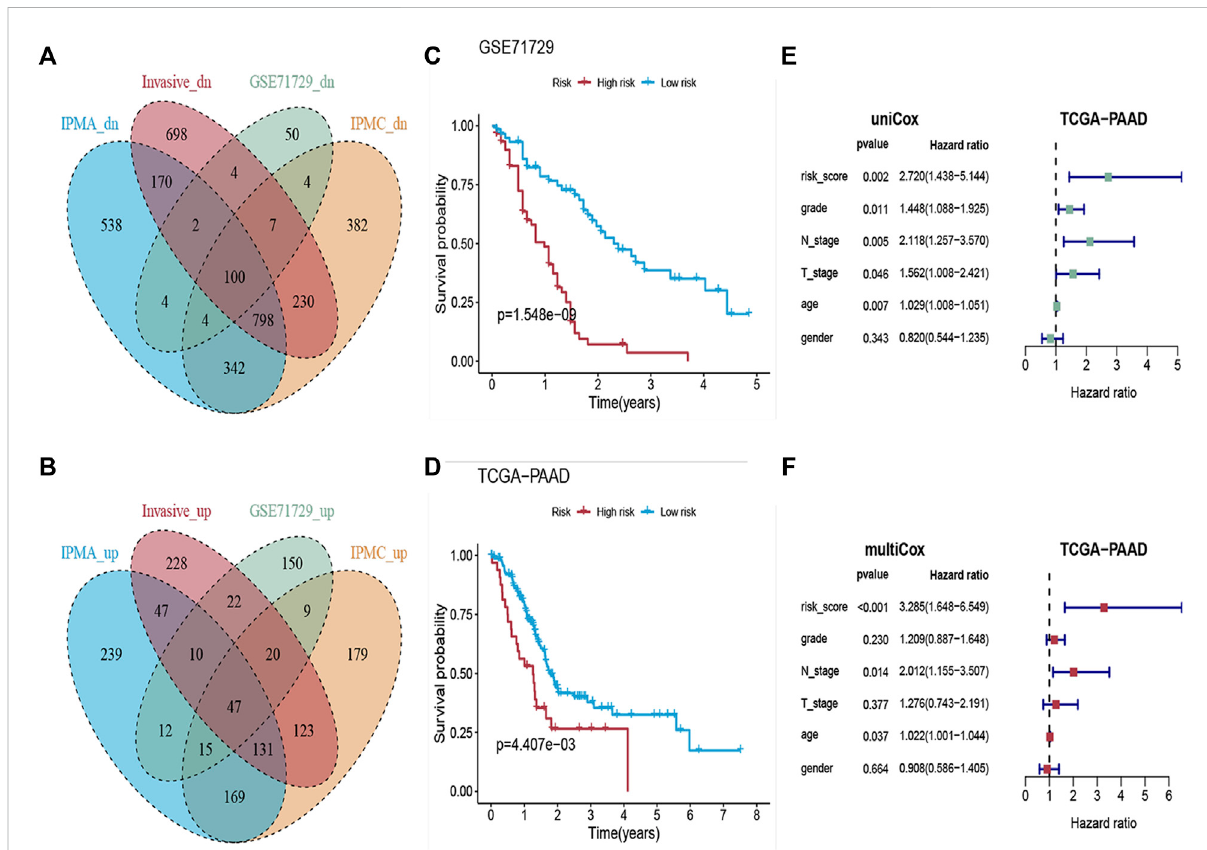
FIGURE 5 ConstructionoftheRisk-ScoringModel. (A,B) Venndiagramshowingtheco-upregulatedandco-downregulatedgenesinIPMA,IPMC,invasive andPDACsamples. (C,D) Kaplan-Meieranalysisforoverallsurvivalaccordingtotheeleven-genesignatureriskscoreinGSE71729andTCGAcohorts. (E,F) Forest plots of the hazard ratios (HRs) with 95% con fi dence interval (95% CI) and p -value of univariate and multivariate Cox